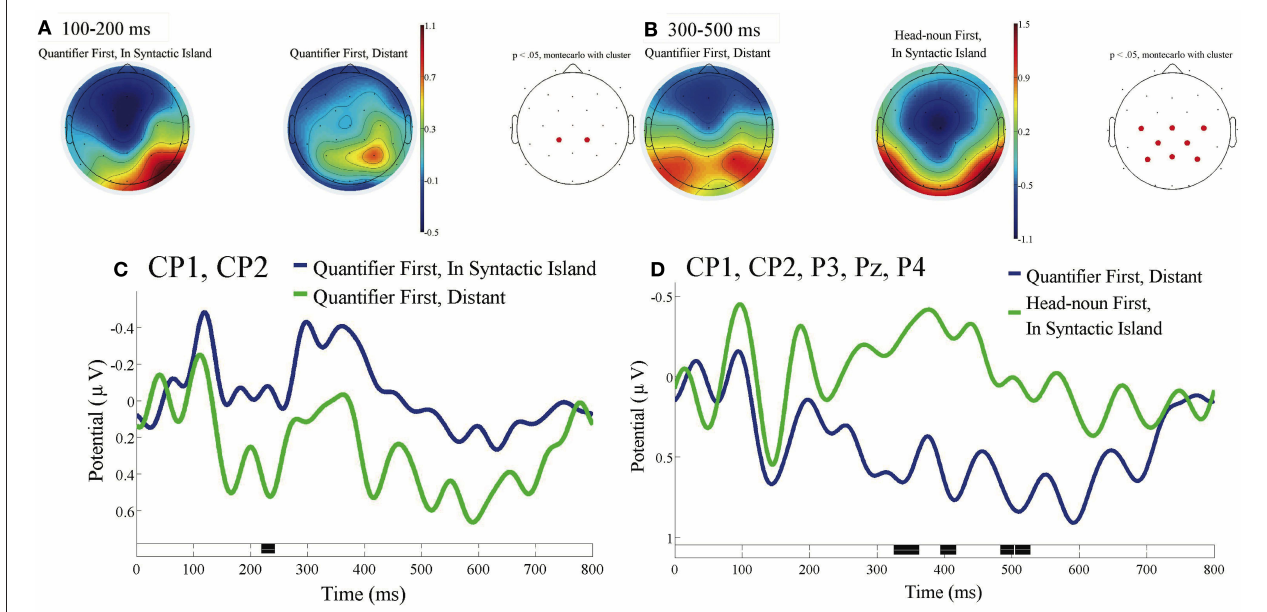
FIGURE 7 | ERPs time-locked to the onsets of the subordinate verbs of In Syntactic Island and of the fifth phrases of Quantifier First, Distant in (A–D) with the baseline as 0 to 100 ms. (A) Mean topographies of the ERPs from 100 to 200 ms for Quantifier First, In Syntactic Island (left) and Quantifier First, Distant (right), and (B) those from 300 to 500 ms for Quantifier First, Distant (left) and Head-noun First, In Syntactic Island (right) conditions; the electrode sites at which significant differences were determined by using the cluster-based permutation test ( p < 0.05) are depicted in red. (C) Mean ERPs of the two conditions at the centro-parietal electrodes (CP1 and CP2) for In Syntactic Island and Distant of Quantifier First and (D) those at the centro-parietal electrodes (CP1, CP2, P3, Pz, and P4) for Quantifier First, Distant and Head-noun First, In Syntactic Island. Negativity is plotted upward, and the time windows during which significant differences were determined by the cluster-based permutation test are indicated in black on the time axes in (C,D)